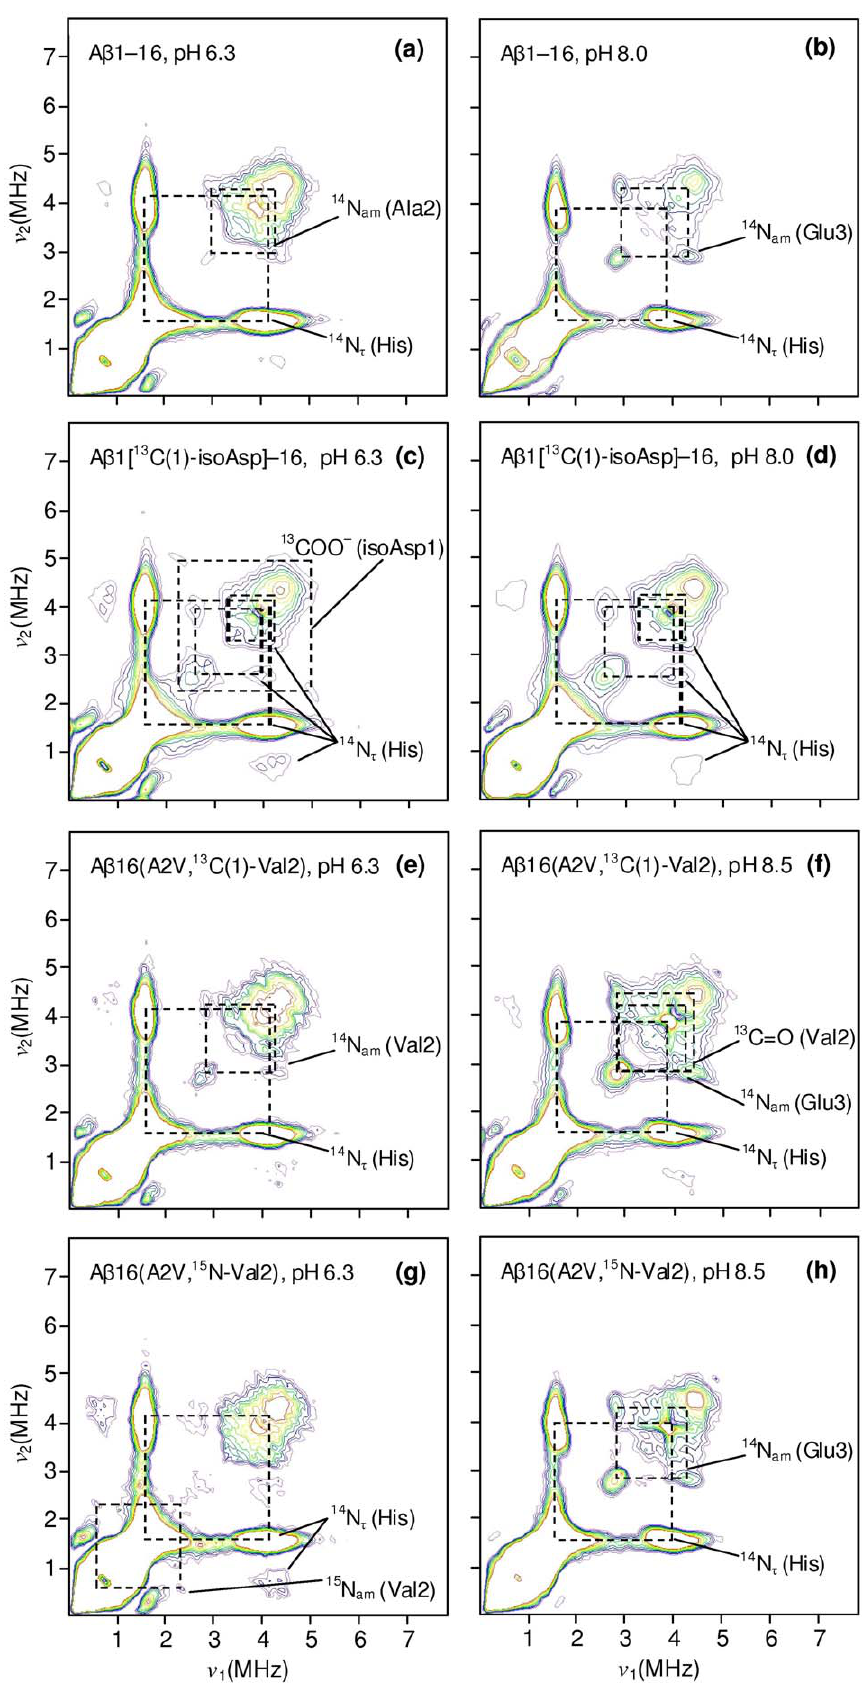
Figure 5. X-band (9.70 GHz) HYSCORE spectra ( t =144 ns) of Cu 2 + /A b 16 analogues (0.9 equiv 65 CuCl 2 ), obtained at 3370 G (near g H ). doi:10.1371/journal.pone.0015875.g005 PLoS ONE |